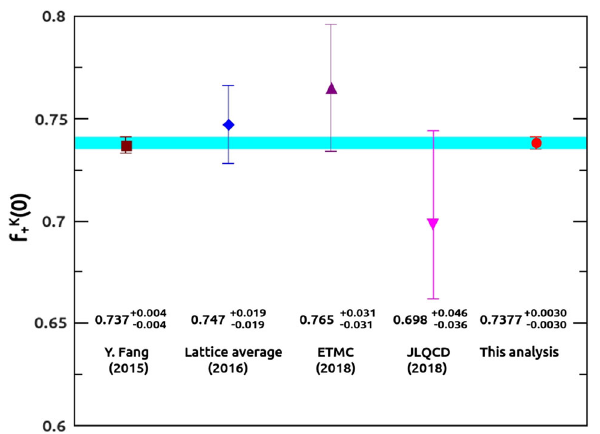
Fig. 3 The f K + ( 0 ) determined with experimental data or Lattice QCD. The values are described in the text. The cyan band is the uncertainty at one standard deviation of this analysis